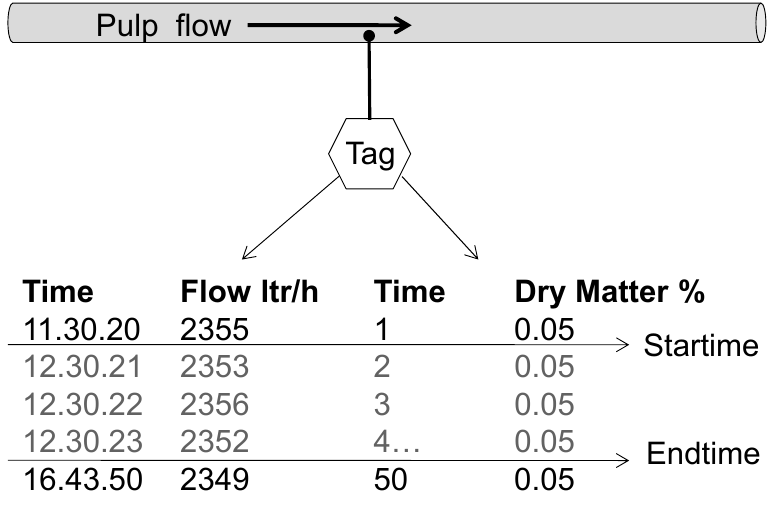
Figure 3. Pulp flow measurements are performed at intervals.